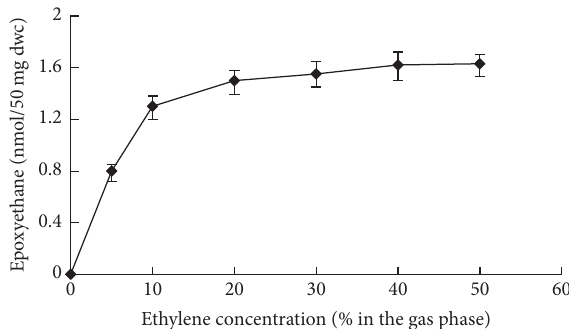
Figure 1: The effect of ethylene concentration on the production of epoxyethanebywholecellsuspensionof Methylosinustrichosporium IMV